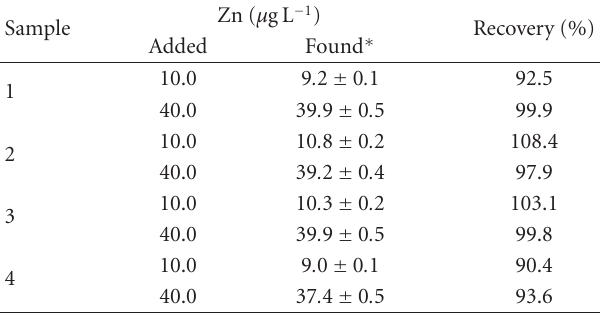
Table 3: Experimental recovery for determination of zinc